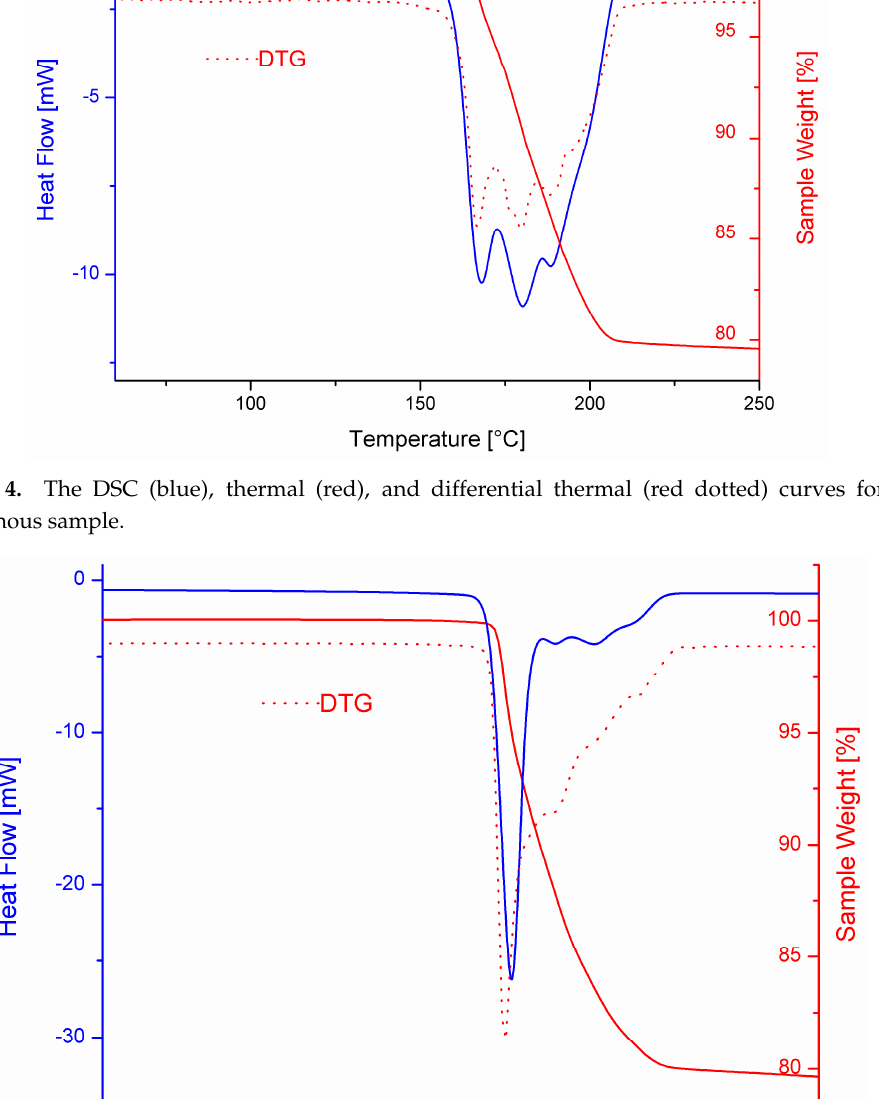
Figure 5. The DSC (blue), thermal (red), and differential thermal (red dotted) curves for the crystalline sample.